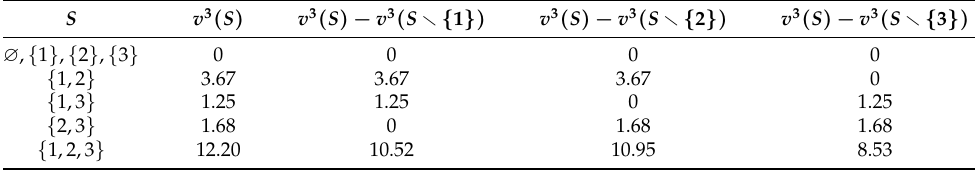
Table 3. Marginal contributions to ∆ p 3